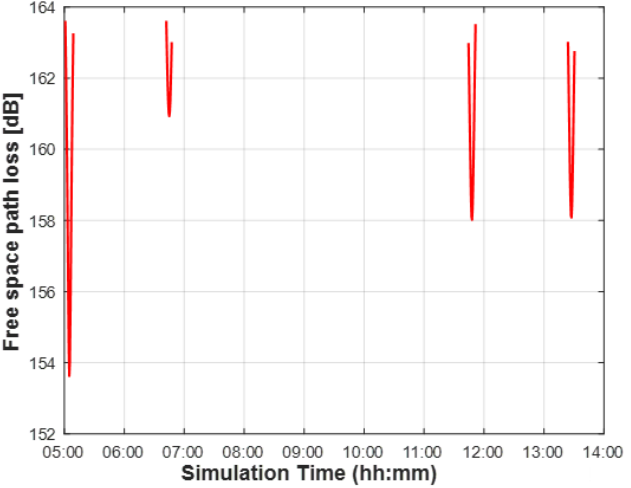
Figure 7. Free space path loss between the reference position (latitude 36.35080 ◦ N, longitude 127.30122 ◦ E) and a satellite receiver over simulation time based on the actual satellite orbit data on 22 February